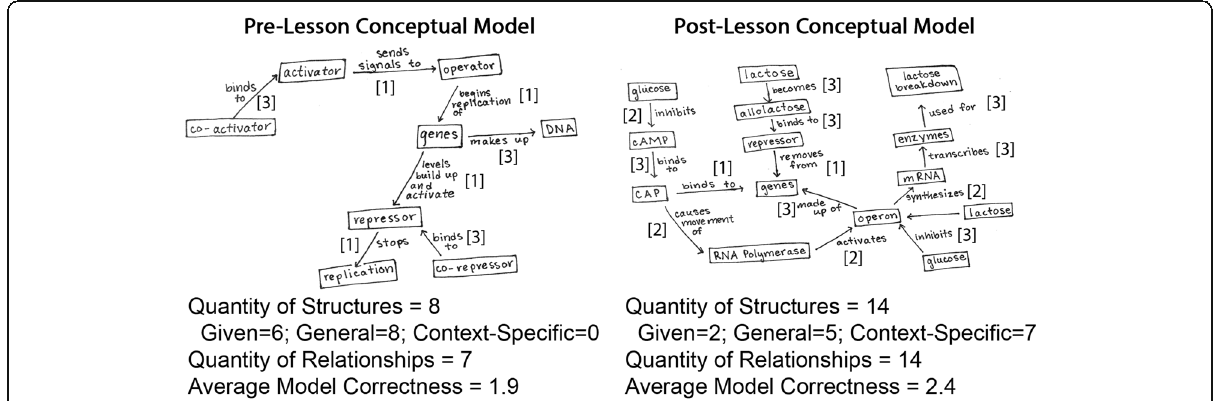
Fig. 3 Student-generated conceptual model on pre-lesson activity and post-lesson activity, showing the changes in representation of the lac operon system. Generally, student post models included more structures (and more context-specific structures) with higher quality